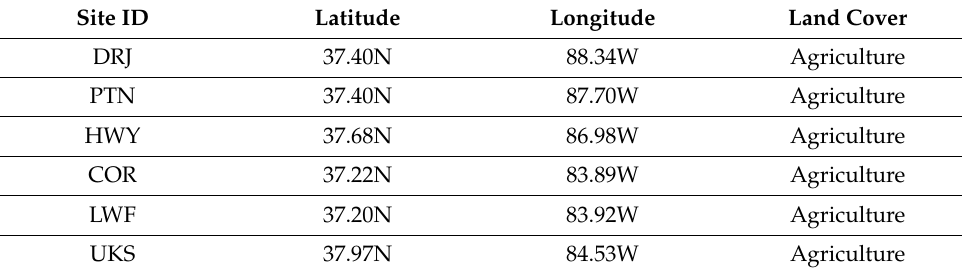
Table 1. Latitude, longitude, and land cover type for the 19 sites used in this